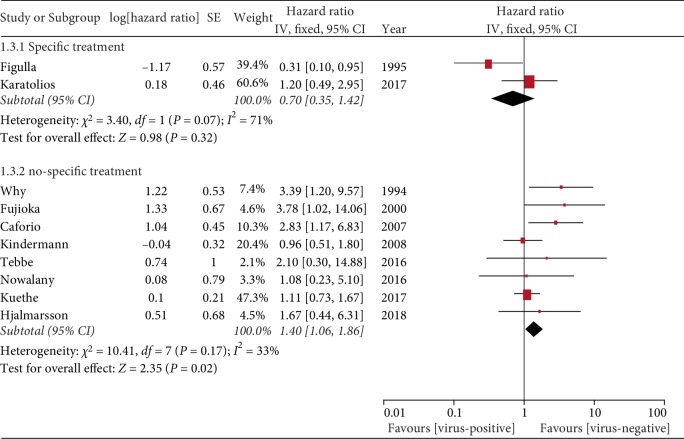
Specific treatment.